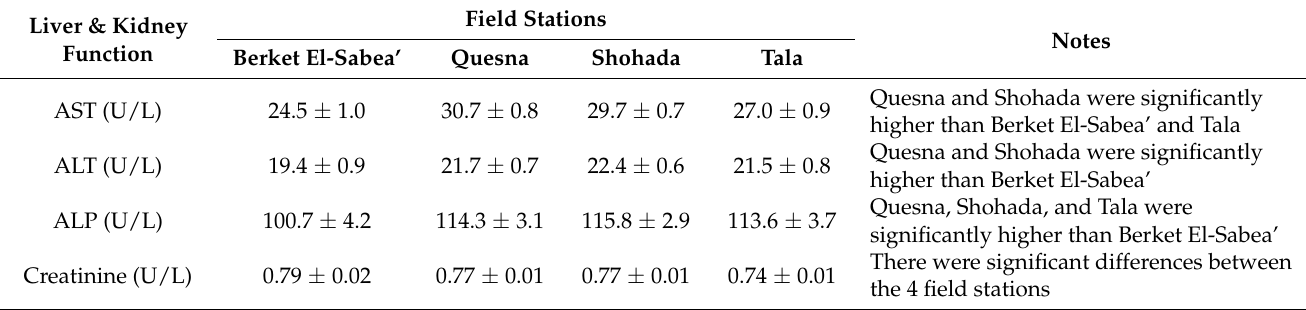
Table 5. Main effects of liver and kidney function measures (least squares mean ± SE) of the study participants at the 4 field stations and the significant difference from the repeated mixed-effects models. Liver & Kidney